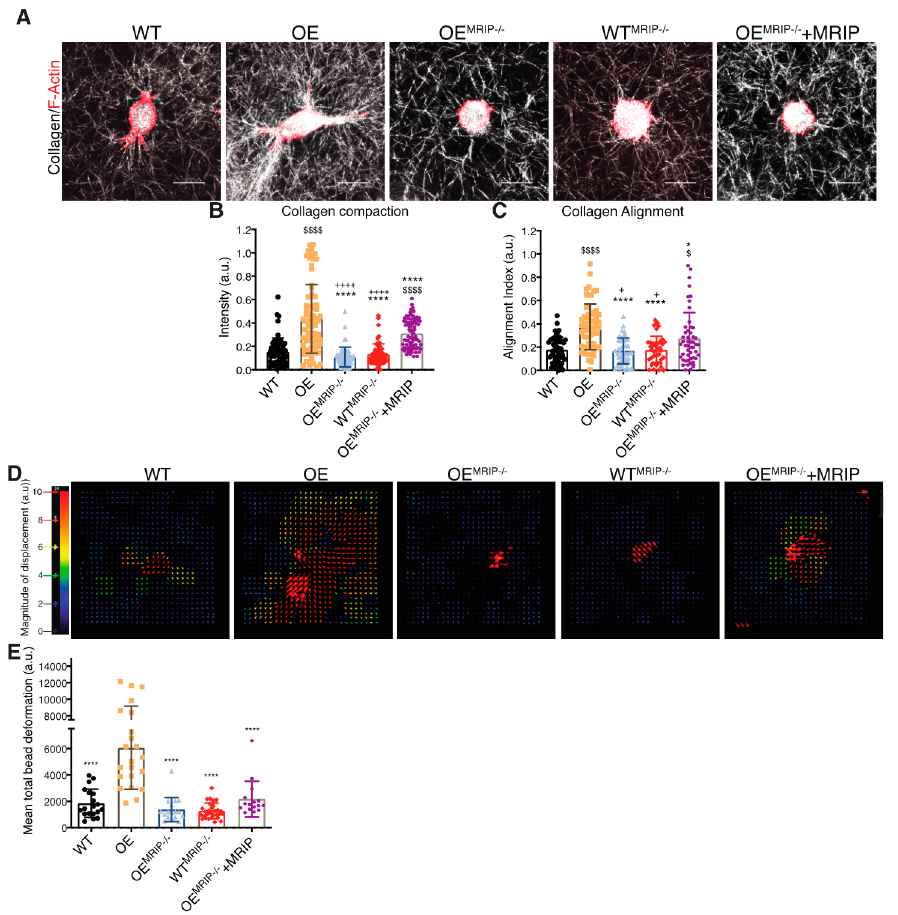
Figure 3. MRIP knockout reduces traction forces and collagen remodeling. ( A ) Representative images of cells cultured on fibrillar collagen gels for 24 h to evaluate and quantify collagen compaction (mean intensity of reflectance signal ( B )), and fiber alignment ( C ). In panel ( D) , collagen tractional remodeling was quantified by analyzing position changes of marker beads embedded in collagen gels over a 10 h sampling period. ( E ) Bead displacement was used to calculate mean cell-induced deformations by particle image velocimetry, which are displayed as vectors with color-coded magnitude as indicated in D. Data are reported as mean ± SD, n = 3. $ , + p < 0.05; $$$$ , ++++ , **** p < 0.0001; $ compared with WT; * compared with OE; + compared with OE MRIP-/- +MRIP. Scale bar, 20 μ m.